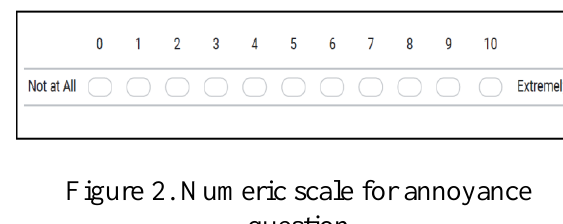
Figure 2. Numeric scale for